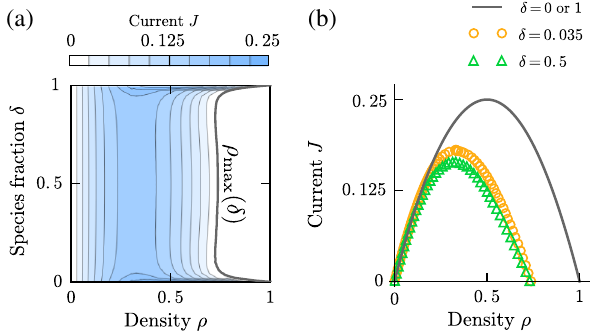
FIG. 2. Current-density relation obtained from stochastic sim- ulations with W ¼ 2 lanes and L ¼ 4096 sites. (a) The emerging current J of an arbitrary lane (blue color) shows a dependence not only on the average system density ρ but also on the fraction of lane-switching particles, δ . The system jams at a maximal δ Þ (bold gray line); densities between ρ density ρ and full max ð max occupation are not realized in any stationary state. (b) Current- density relation for mixed species ( δ ¼ 0 . 5 , δ ¼ 0 . 035 , symbols) and single species ( δ ¼ 0 or 1, line). For the latter cases, we recover the TASEP current-density